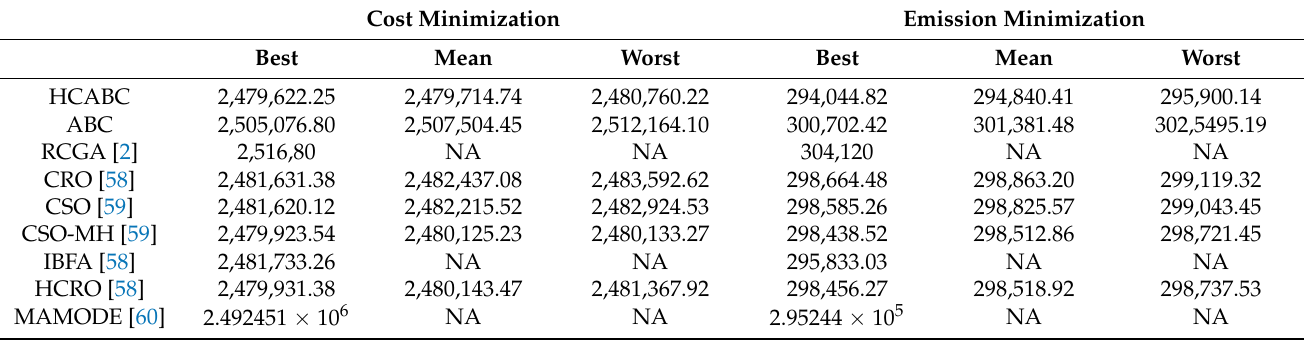
Table 8. Statistical results for case